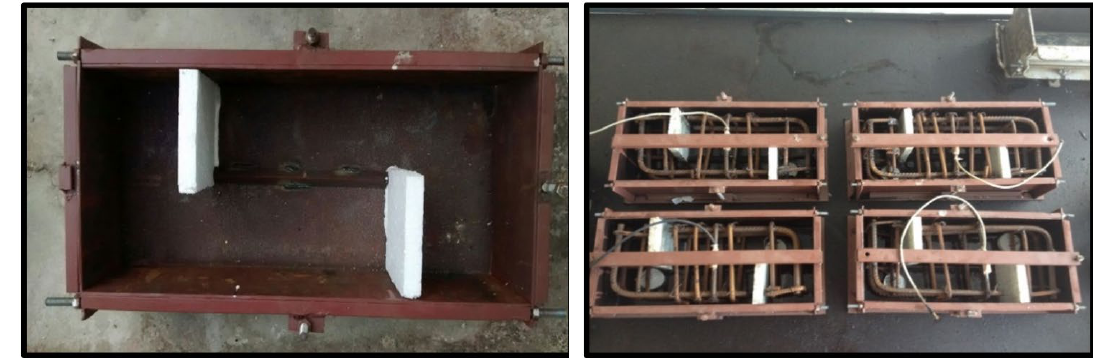
Figure 4. Metallic form for the production of push-off specimens [15].